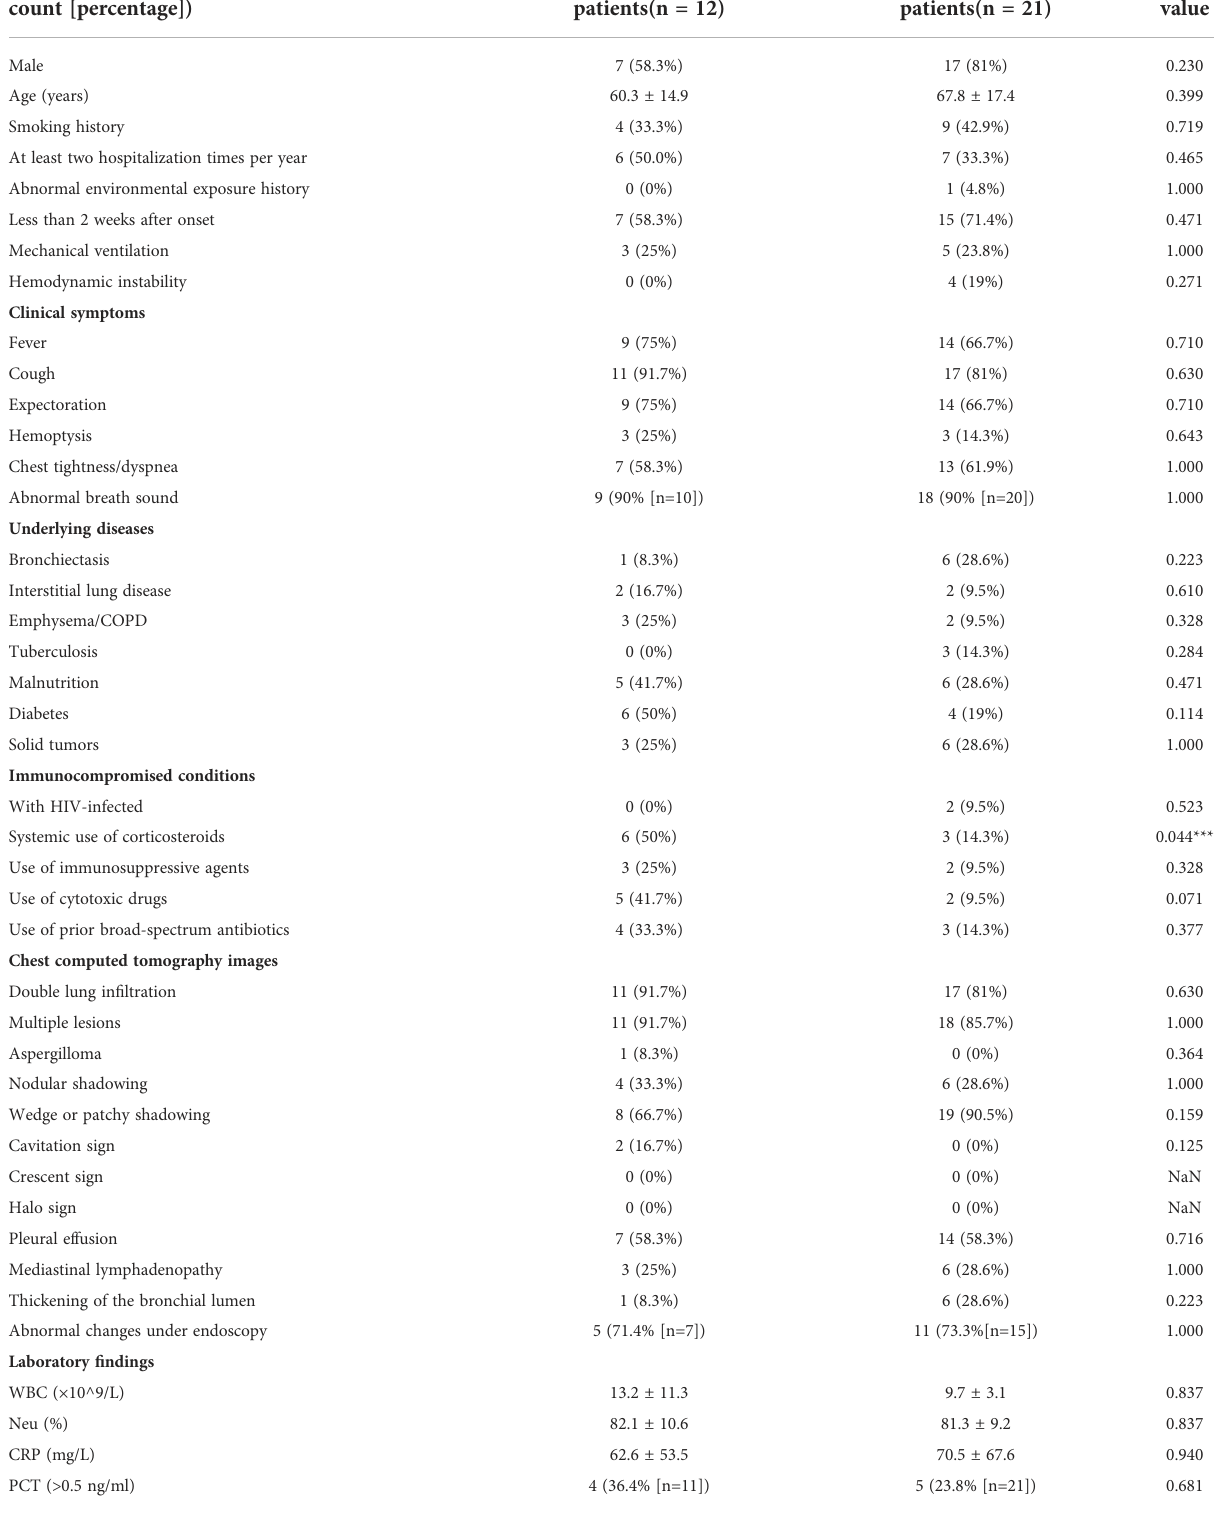
TABLE 1 Clinical characteristics, laboratory tests, and radiologic features of pulmonary aspergillosis and non-pulmonary aspergillosis in non- neutropenic patients on admission. Characteristic (mean± [standard deviation]